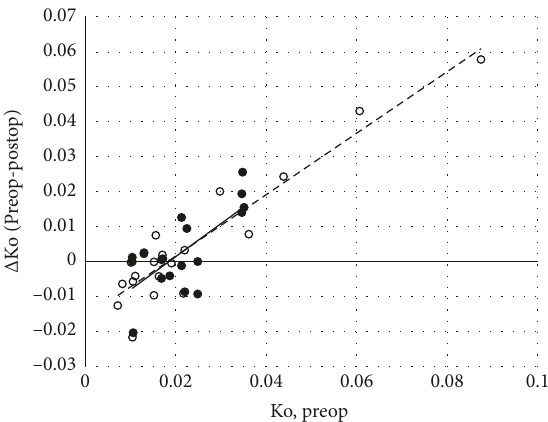
Figure 2: Change in Ko and preop Ko. The filled and empty circles are, respectively, the results according to measurements obtained by operators 1 and 2. The solid and dashed lines are the corre- sponding least squares regression